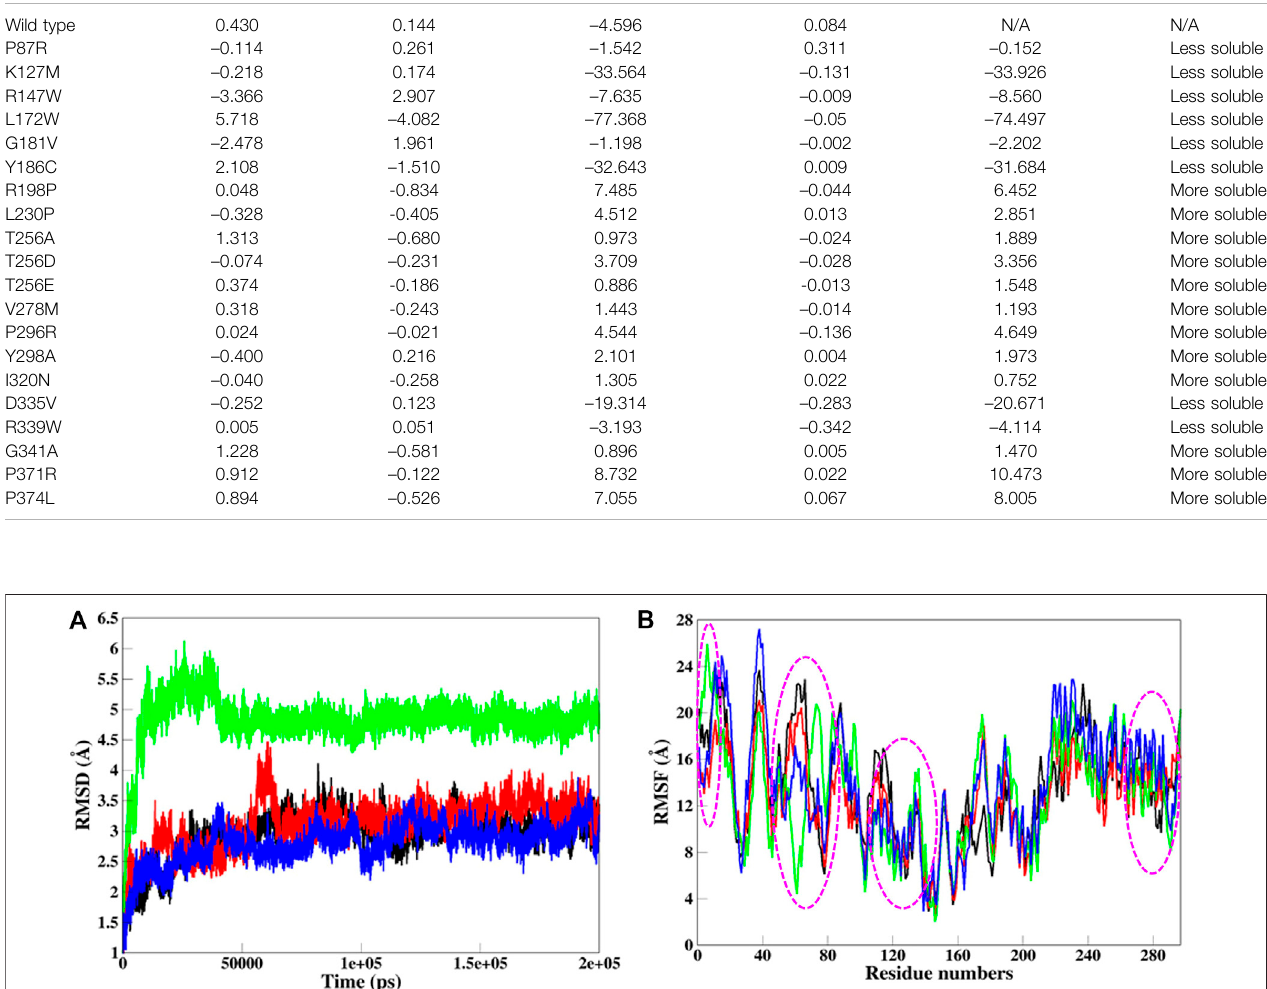
Frontiers in Molecular Biosciences |